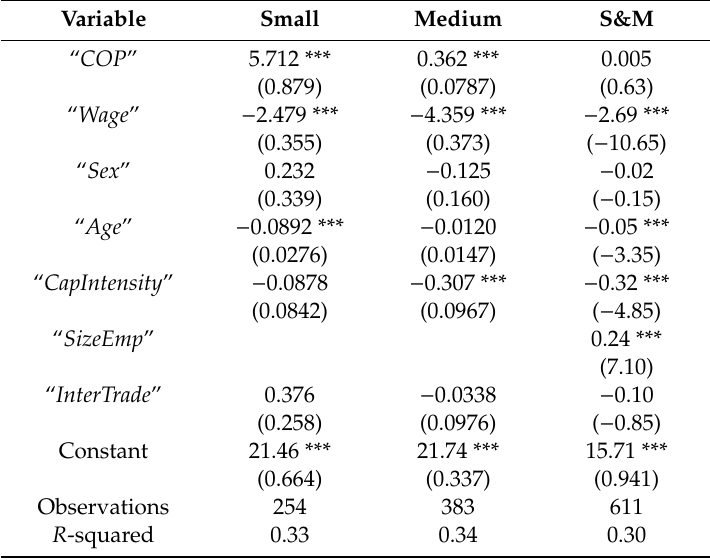
Table 3. Regression results for small and medium sized